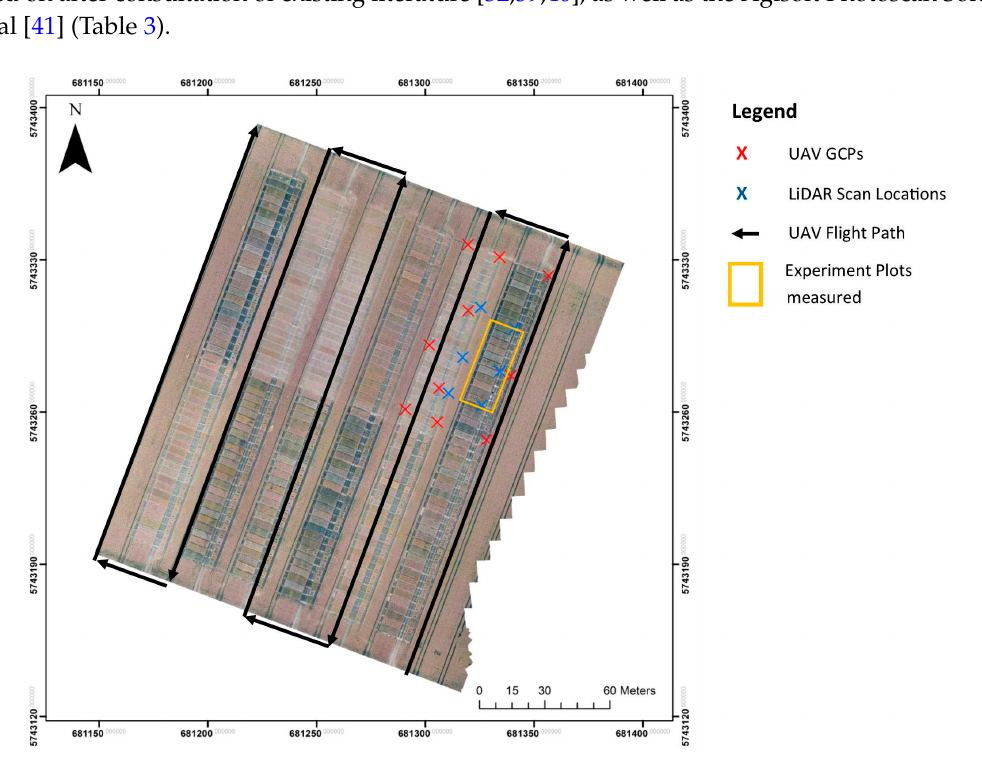
Table 3. Camera settings and image parameters used for the two data collection flights made during 2014.